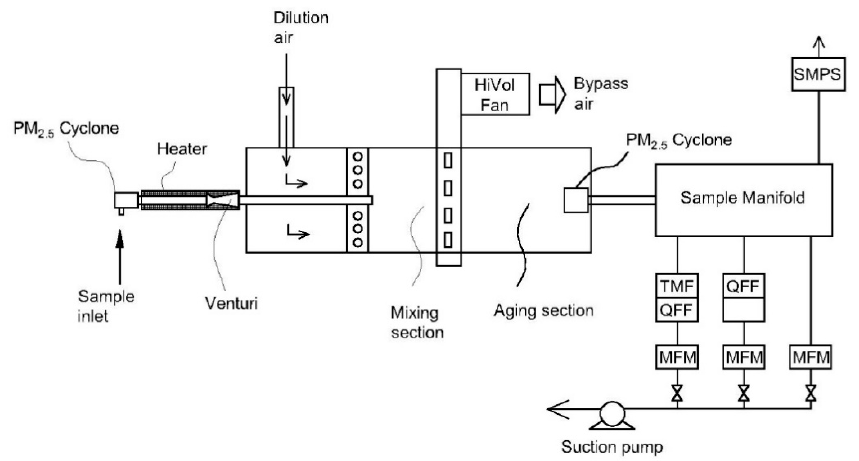
Figure 11. Schematic diagram of a compact dilution system invented by England et al. [112]. (TMF: Teflon membrane filter, QFF: quartz fiber filters, SMPS: scanning mobility particle sizer, MFM: mass flow meter).